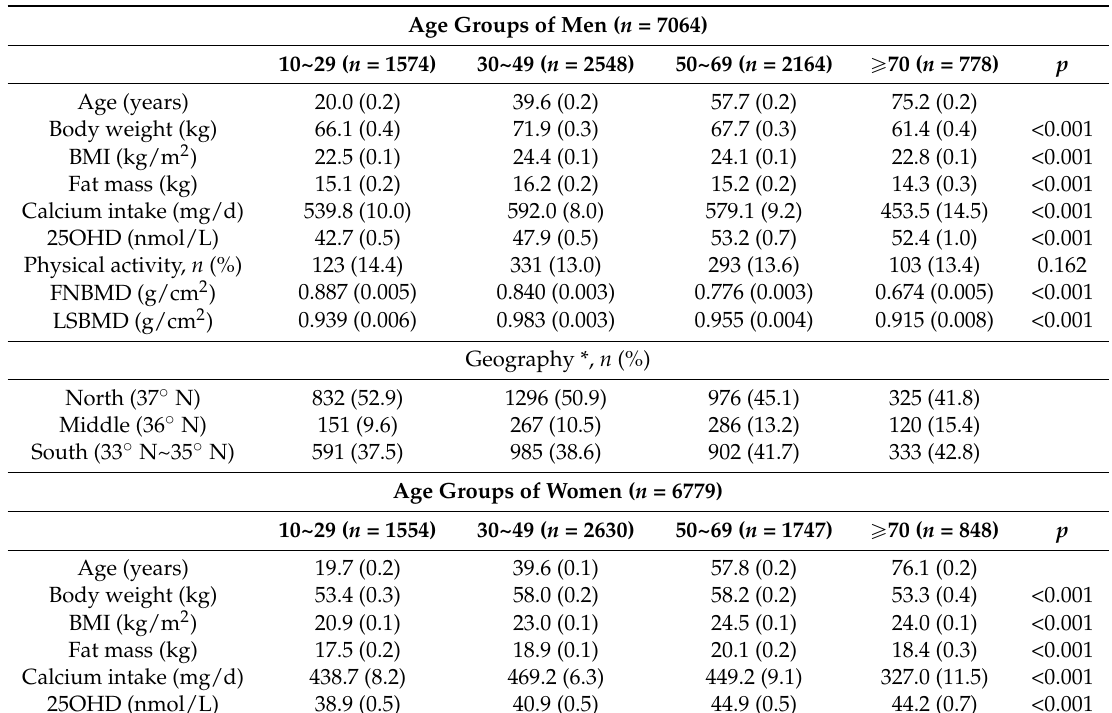
Table 2. General characteristics of study subjects categorized by